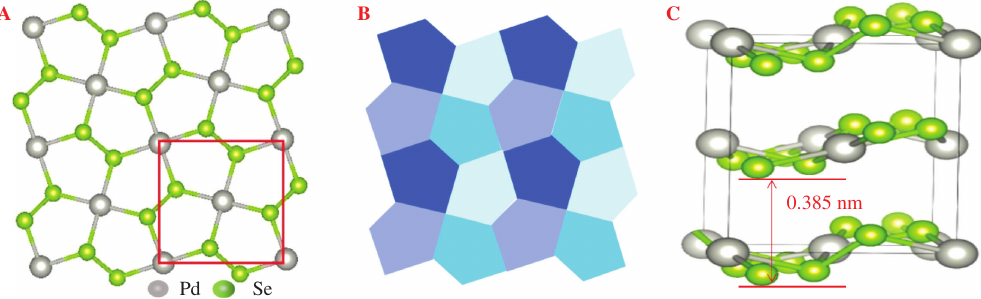
. Figure 1: Atomic structures of PdSe 2 (A) Top view of a 2 × 2 × 1 supercell of the single-layer PdSe . (B) A sketch of the Cairo tessellation formed from pentagons. (C) Side view of 2 the three-layer PdSe 2